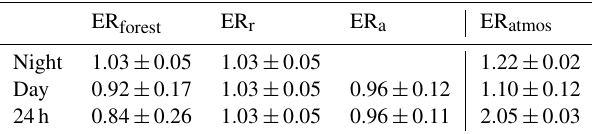
Table 3. The exchange ratio for the atmosphere (ER atmos : Sect. 3.2), the forest (ER forest : Sect. 3.3), and assimilation and res- piration (ER a and ER r : Sect. 3.3) for different time periods of the representative day. The time periods used to calculate the signals are the following: 09:00–13:00 for day and 23:00–04:00 for night of ER atmos and 09:00–17:00 for day and 21:00–04:00 for night of ER forest , ER r , and ER a . Note that the uncertainty for ER atmos does not represent the same uncertainty as for ER forest , since the first is the error of the fit, and the second is based on error propagation of the half-hourly